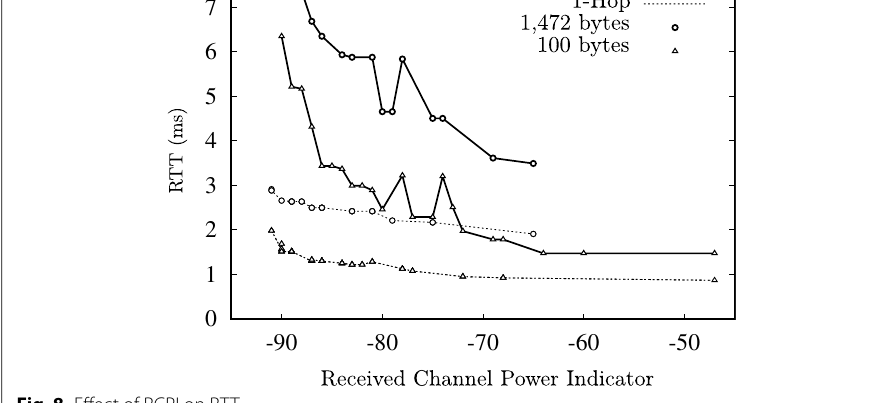
Fig. 8 Effect of RCPI on RTT